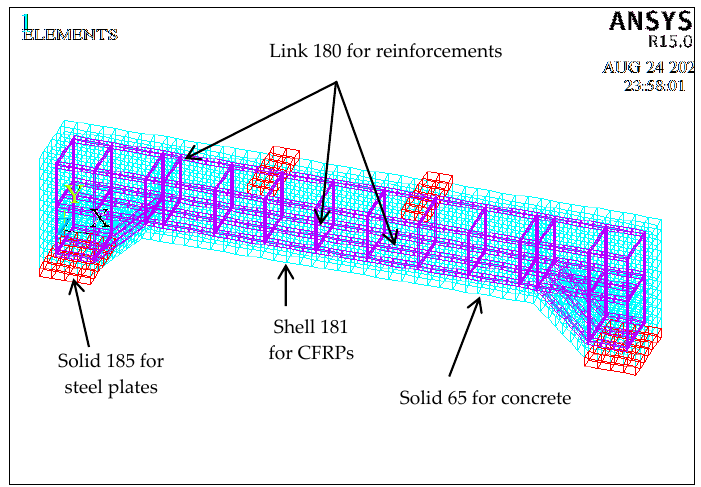
Figure 7. Details of various element for all materials of a typical RC beam model.